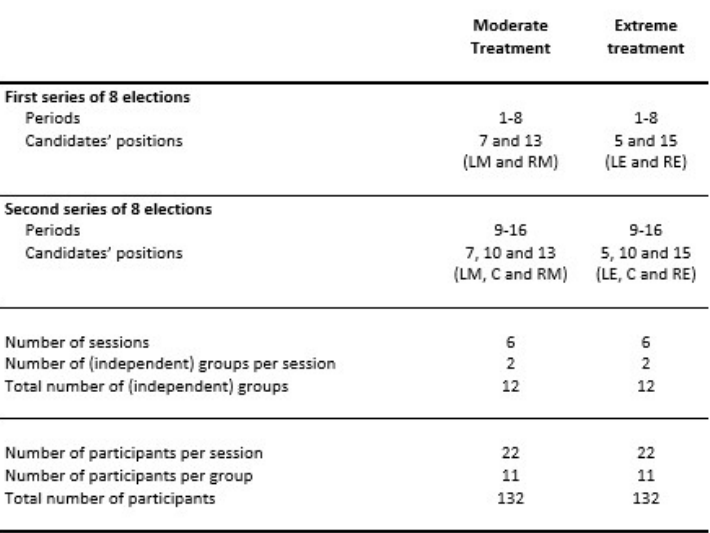
Figure 2. Experimental